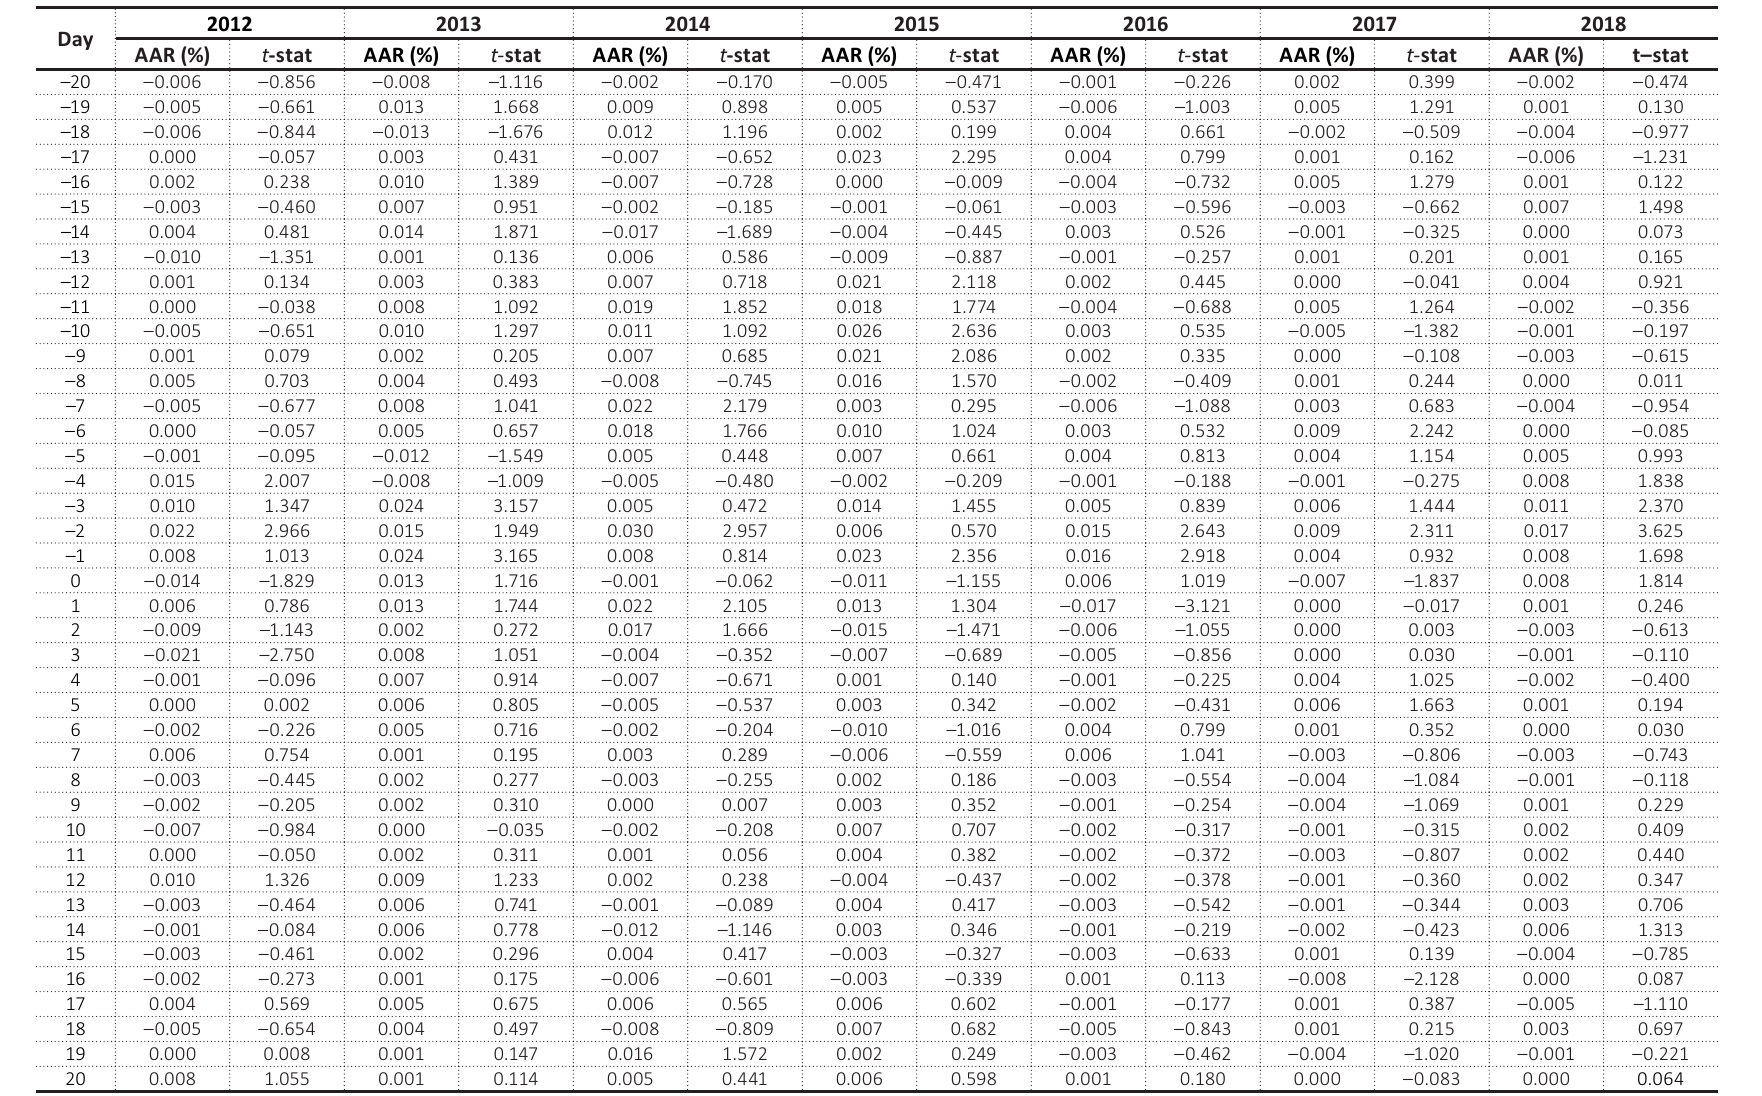
Table 3. Year-wise analysis of AAR